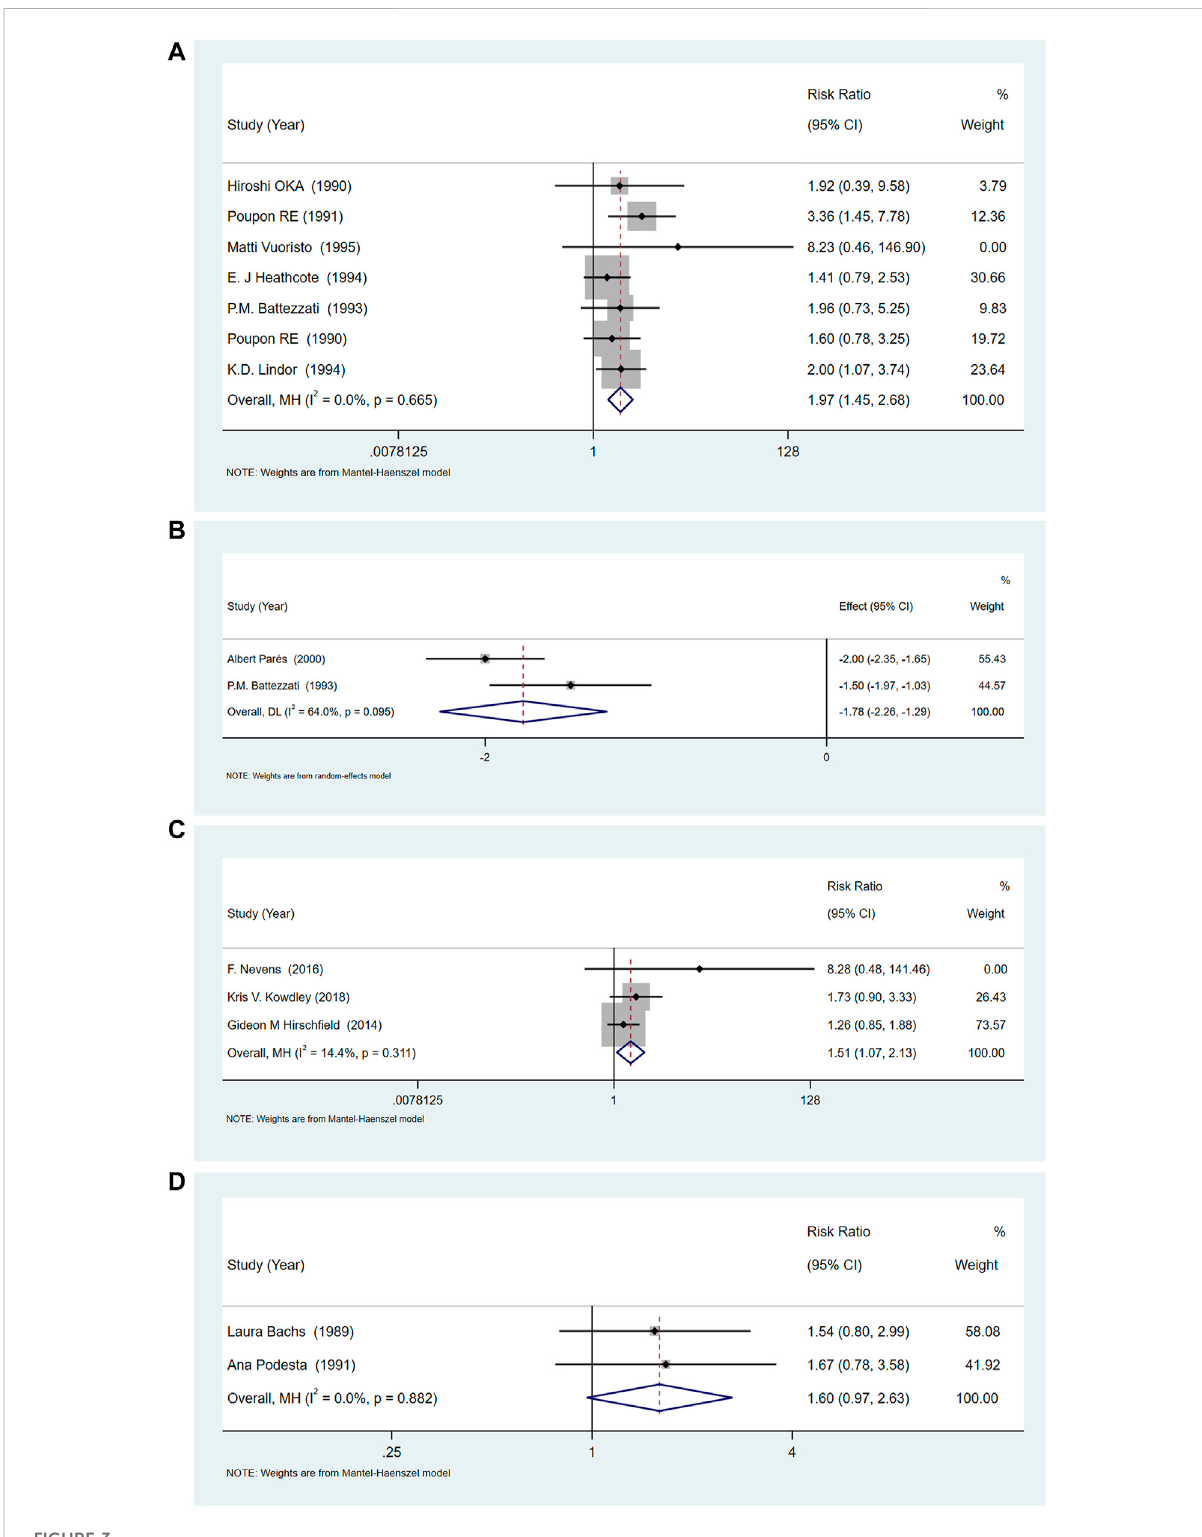
FIGURE 3 (A) The effect of UDCA on pruritus relief compared with placebo. (B) Two studies of UDCA in pruritus scores compared with placebo. (C) OCA increases the risk of pruritus compared with placebo. (D) The effect of Rifampicin on the rate of pruritus relief compared with